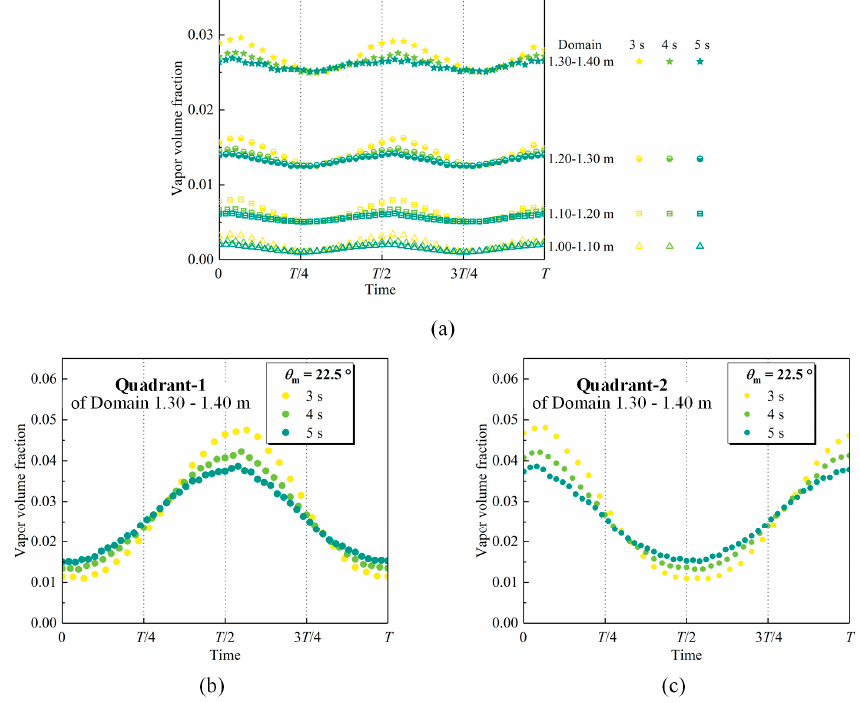
Figure 13. Effect of the period on the vapor volume fraction. ( a ) Domain; ( b ) Quadrant-1 of Domain 1.30–1.40 m; ( c ) Quadrant-2 of Domain 1.30–1.40 m. 1.30–1.40 m; ( c ) Quadrant-2 of Domain 1.30–1.40